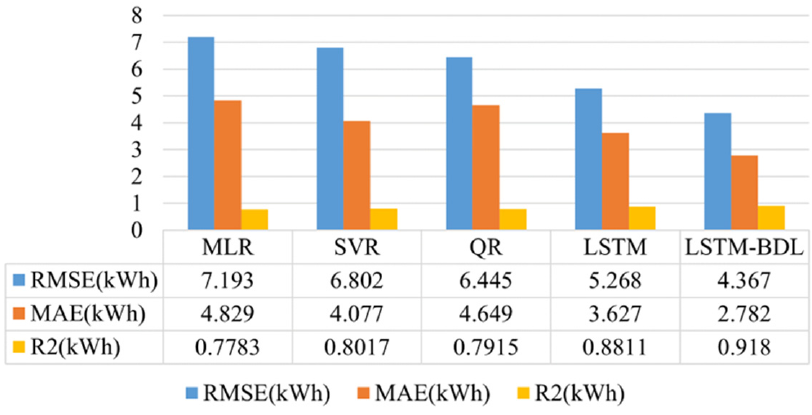
Figure 4. Forecasting results for different methods.